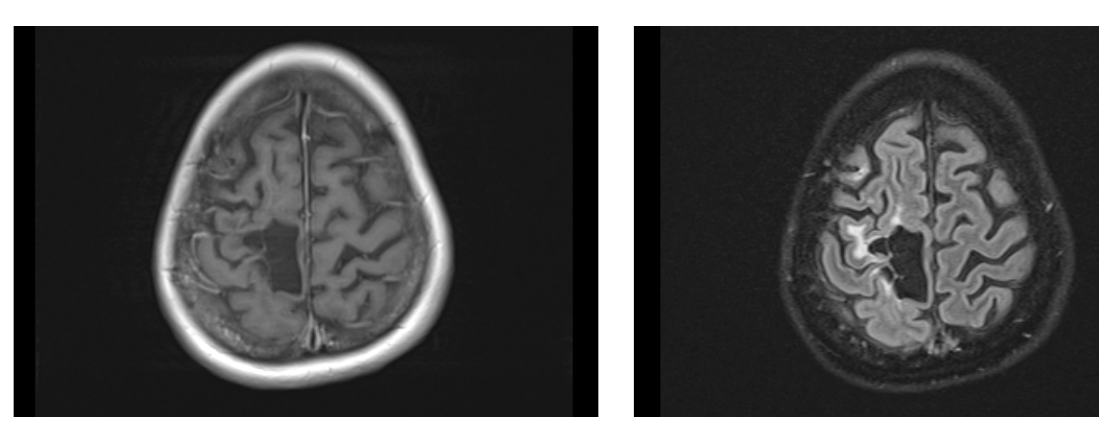
Fig. 1j. Axial diffusion-weighted MRI scan showing reduction in multilocal hyperintensity.